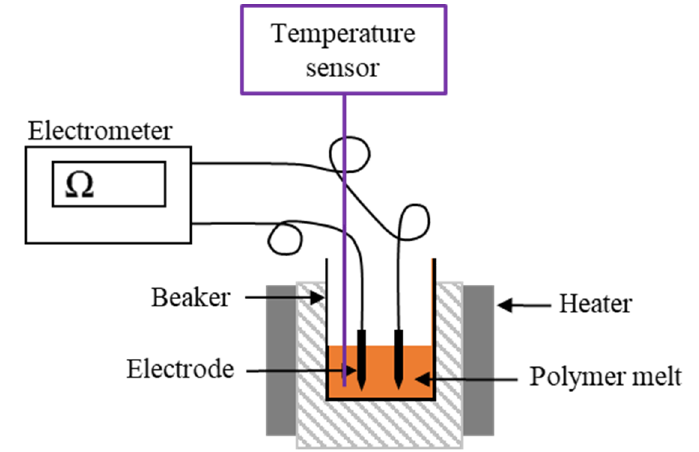
Figure 2. Schematic illustration of our electrometer